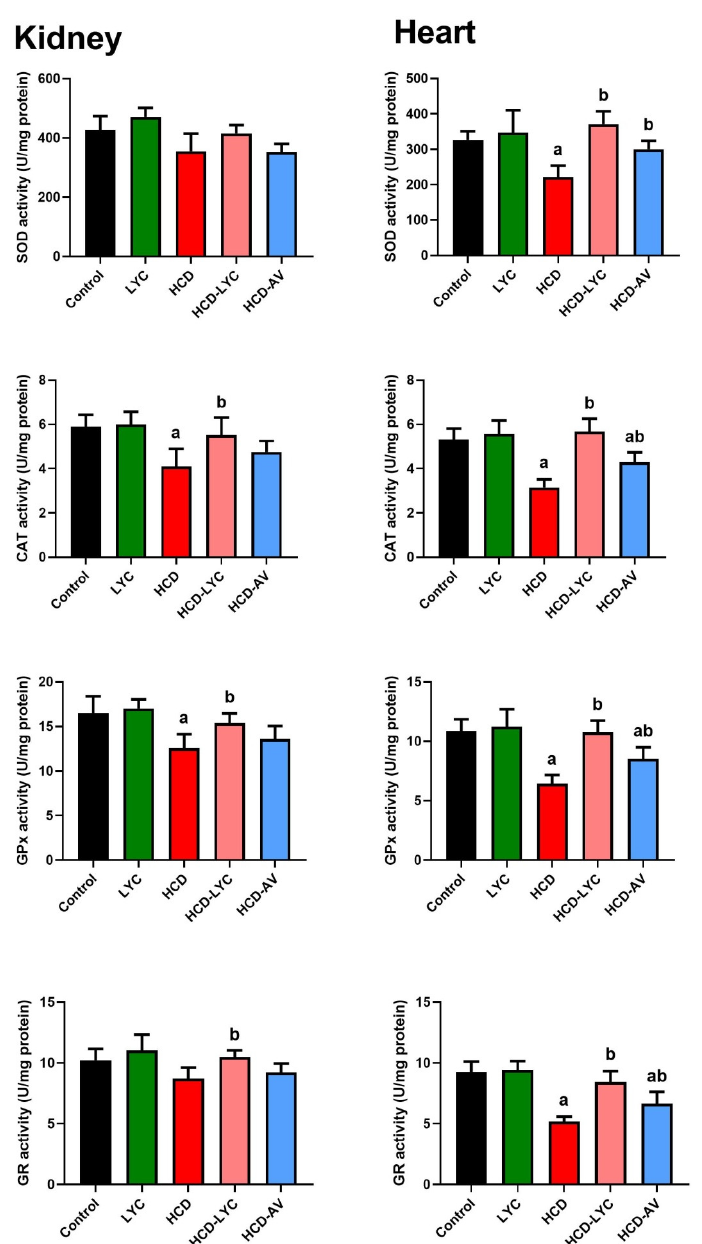
Figure 4. Effects of dietary cholesterol and lycopene on cardiac and hepatic superoxide dismutase (SOD), catalase (CAT), glutathione reductase (GR), and glutathione peroxidase (GPx) activities in rats over 12 weeks. Letters a and b indicate statistically significant differences between control and HCD groups, respectively, at p < 0.05.